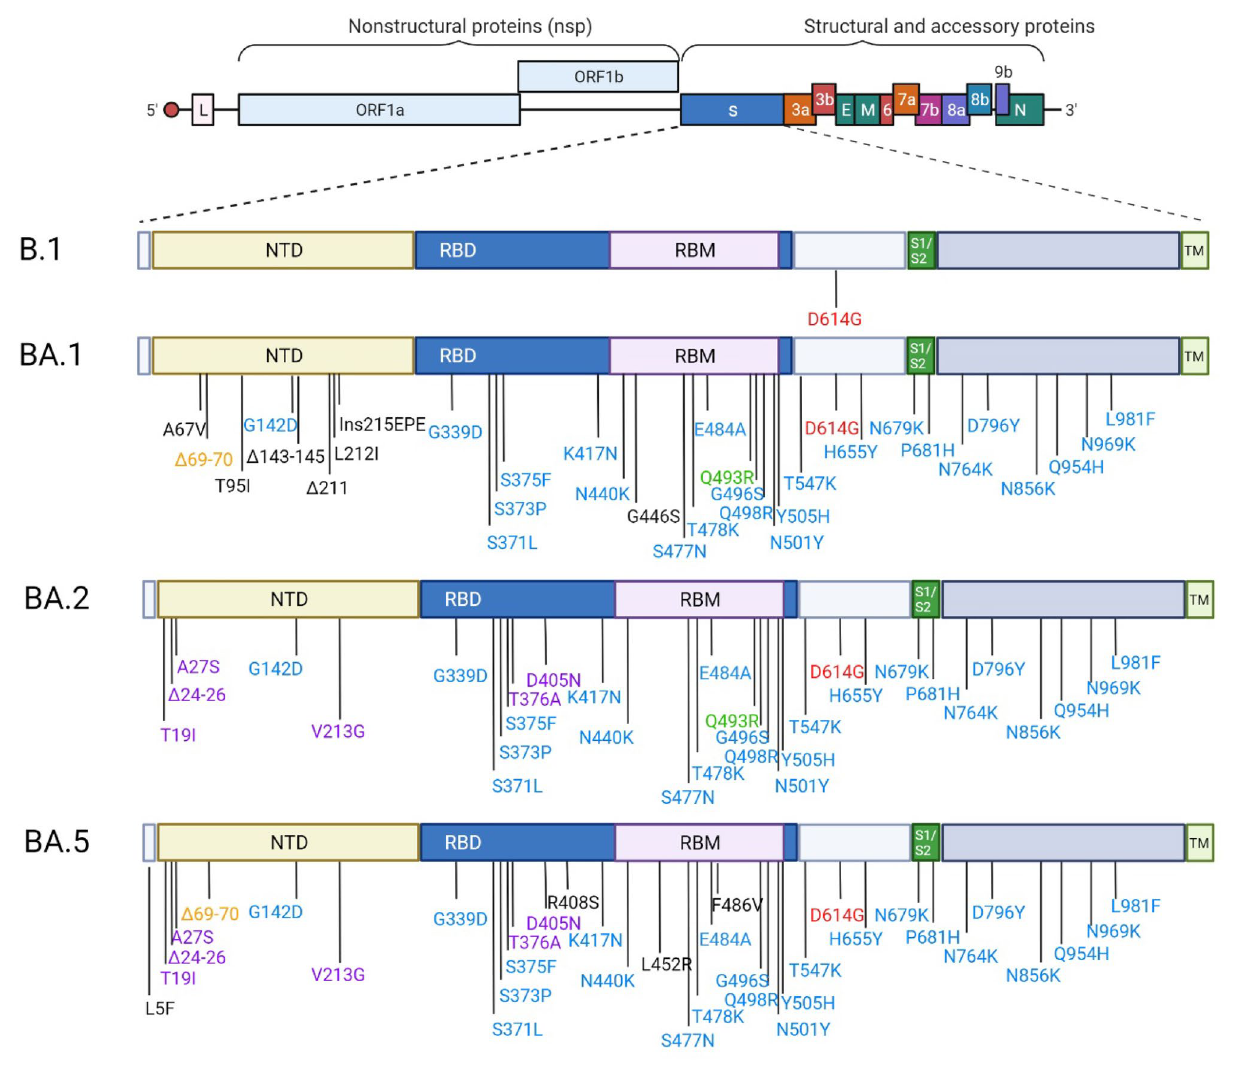
Figure 1. Spike substitutions in SARS-COV-2 variants Omicron BA.1, BA.2 and BA.5 compared to the ancestral strain B.1. Omicron BA.1, BA.2 and BA.5 sequences used for the representation are the one from the strains used in this study BA.1:EPI_ISL_7899754, BA.2: EPI_ISL_9426119 and BA.5: EPI_ISL_12852091. Red color indicates the mutation that is present in all strains. The blue color indicates the mutations which are common to BA.1, BA.2 and BA.5. The orange color indicates the mutations which are common to BA.1/ BA.5. The purple color indicated the mutations which are common to BA.2/BA.5. This figure was created with BioRender.com